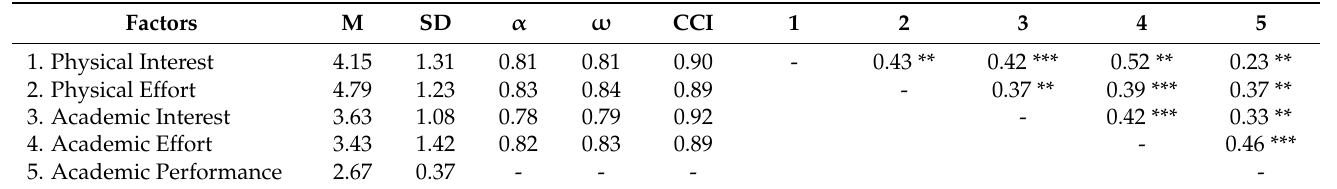
Table 3. Descriptive statistics, reliability analysis, bivariate correlations and temporal stability analysis.